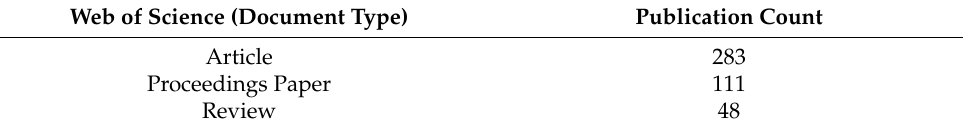
Table 6. Publication count by type (WoS core